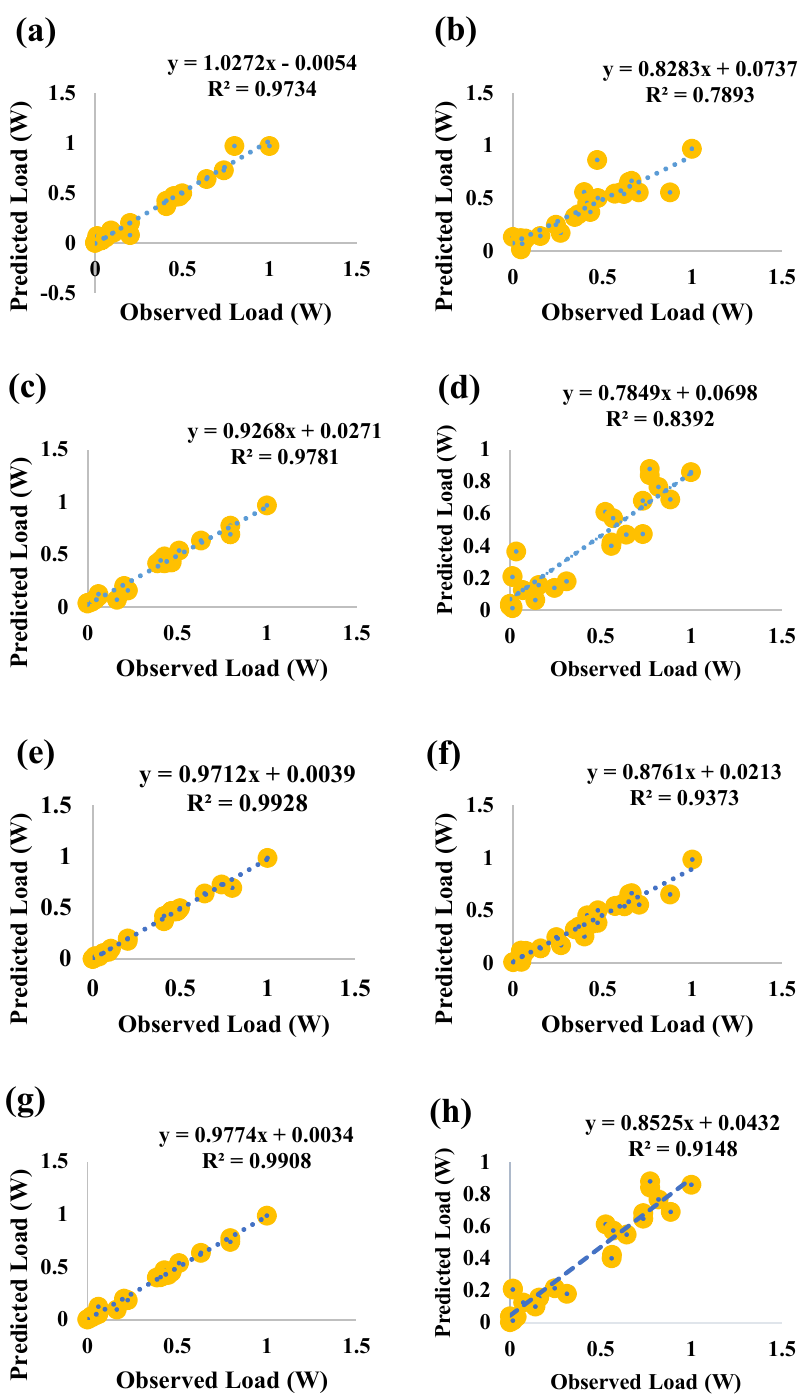
Figure 10. Scatter plot for SVR-PSO (( a ) Kano, ( b ) Abuja, ( c ) Niger, ( d ) Lagos), and SVR-HHO (( e ) Kano, ( f ) Abuja, ( g ) Niger, ( h ) Lagos).